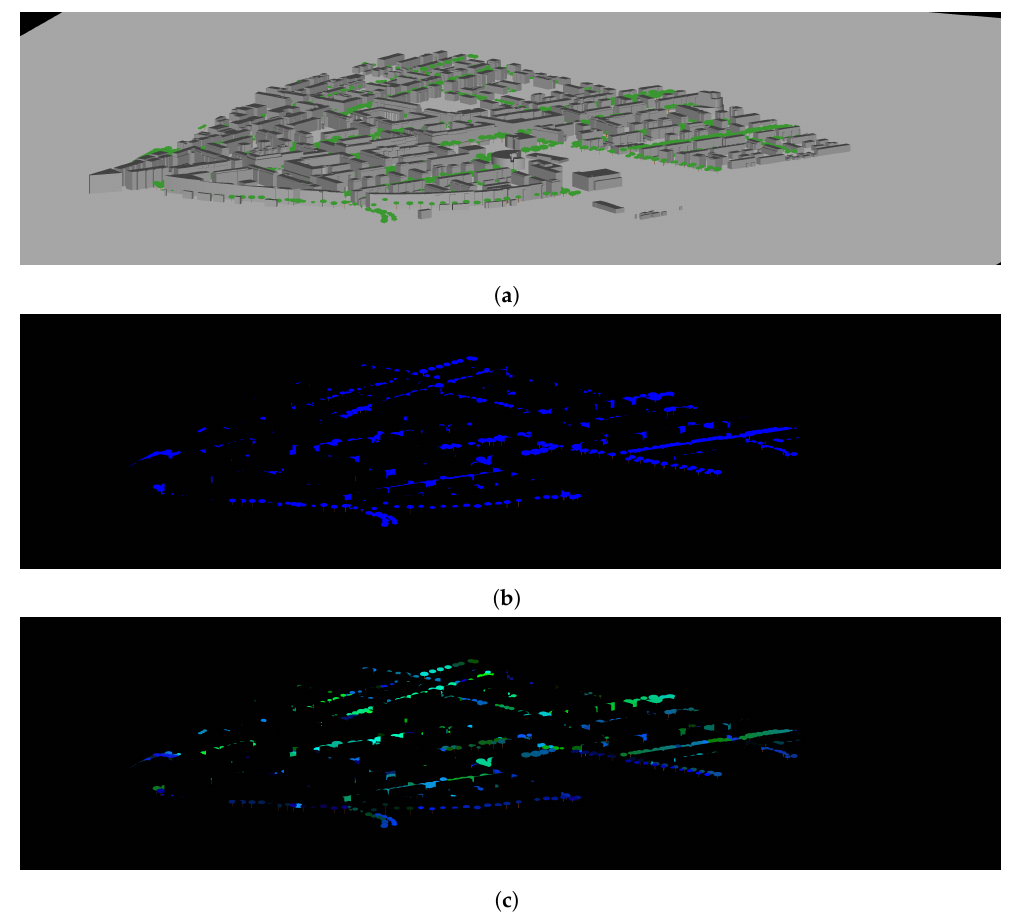
Figure 4. Orthographic, rendered picture showing the sunlit, projected tree surfaces in the study area Rieselfeld in Freiburg, Germany at 05:00 UTC, Solar altitude: 12.5°, Solar azimuth: 68.9°. ( a ) shows the original, unmodified scene, as seen in the 3D view of SkyHelios. ( b ) shows all sunlit trees in the scene in blue, while all other entities (e.g., buildings and ground surface) in the scene are rendered in black. ( c ) encodes unique tree identifiers with RGB-colors, while all other entities are still rendered in